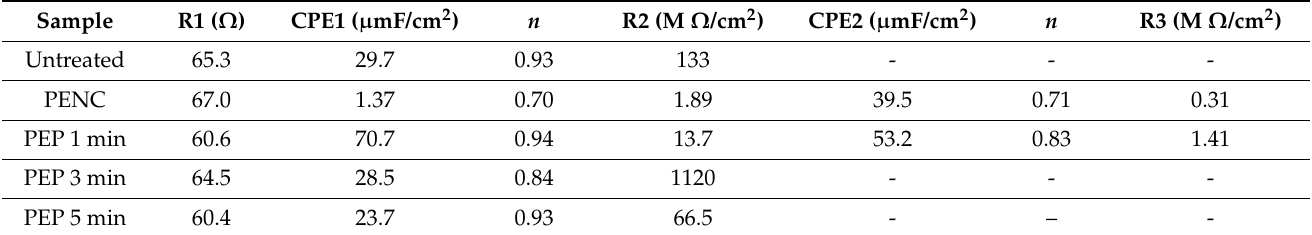
Figure 11. Equivalent electrical circuit model used for impedance data fitting: ( a ) for the untreated samples and the PEP for 3 and 5 min samples; ( b ) for the PENC and PEP for 1 min treated samples. Table 5. Various electrical parameter values obtained after equivalent circuit fitting.